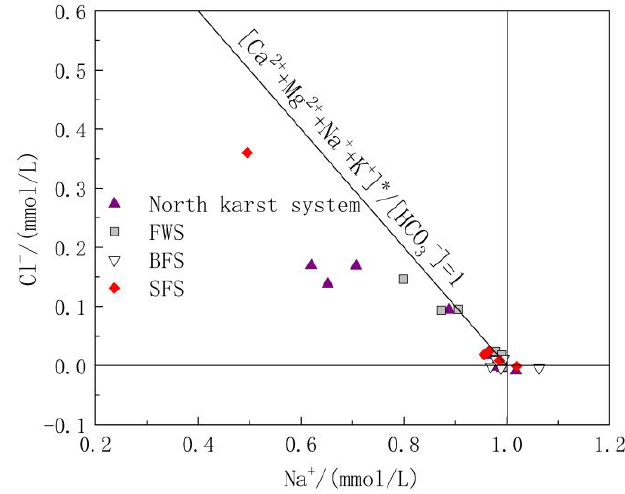
Figure 5. Relative contribution of weathering of carbonate and silicate rocks. Int. J. Environ. Res. Public Health 2020 , 17 , x FOR PEER REVIEW